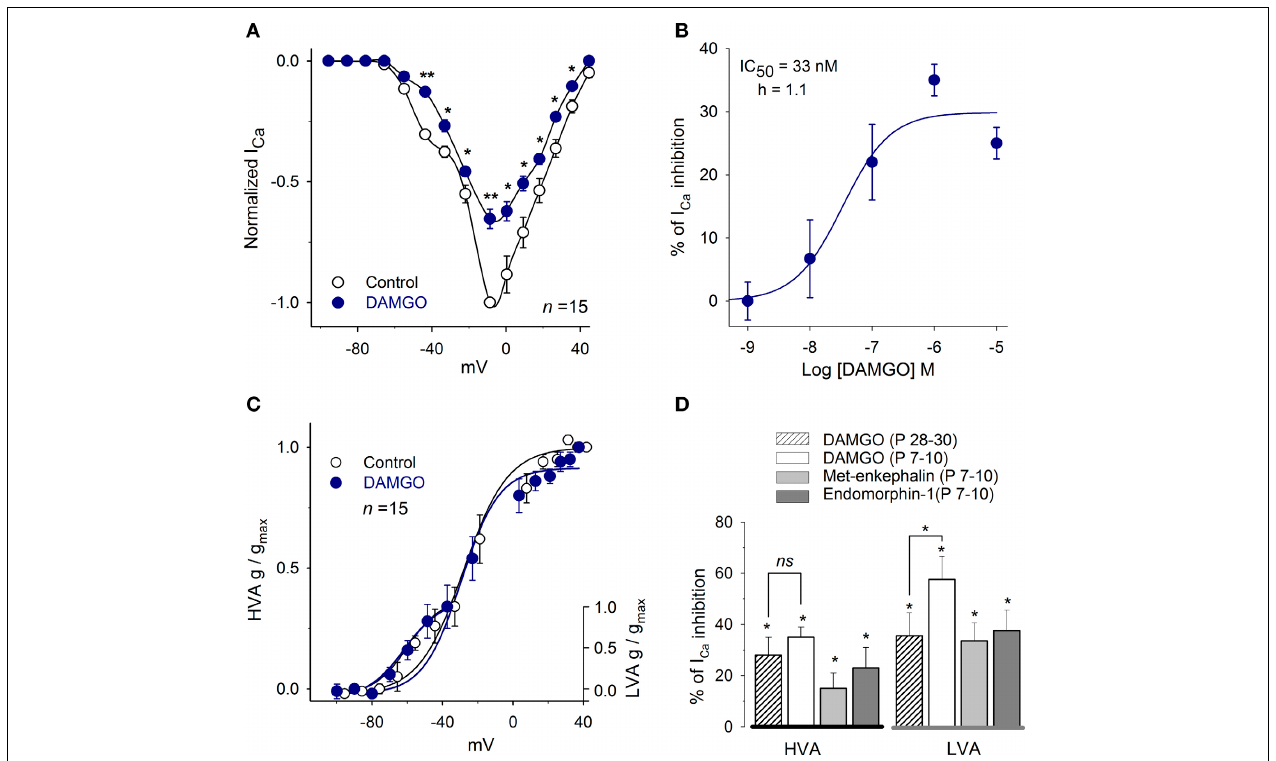
of 1 μ M DAMGO did not significantly modify the parameters of the Boltzmann fit (V 1 / 2 and S) to the conductance of the LVA or HVA components. (D) Bar graph showing the inhibitory action of 1 μ M DAMGO, 1 μ M Met-enkephalin and 1 μ M endomorphin-1 on the HVA (measured at the peak of the I-V relationship) and the LVA (measured at − 50mV) components. (Statistical significance ∗ P < 0 . 05, ∗∗ P < 0 .